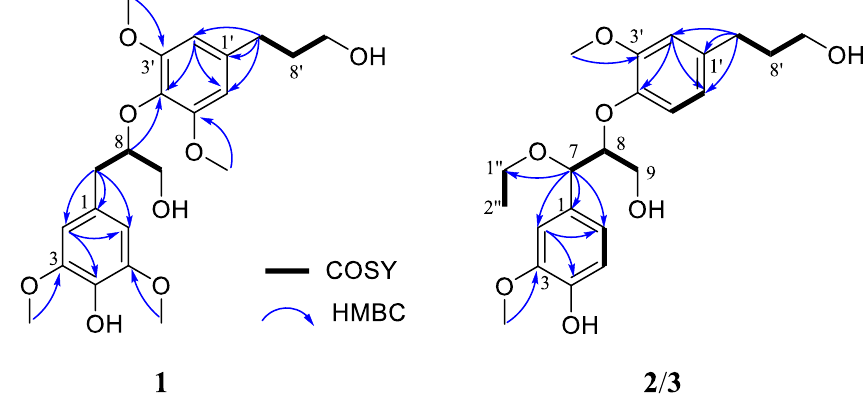
Figure 2. 1 H- 1 H COSY and key HMBC correlations of compounds 1 – 3.